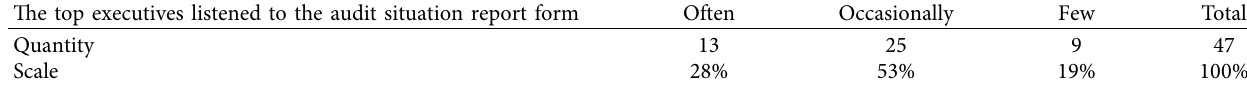
Table 2: Reports on high-level audit listening in